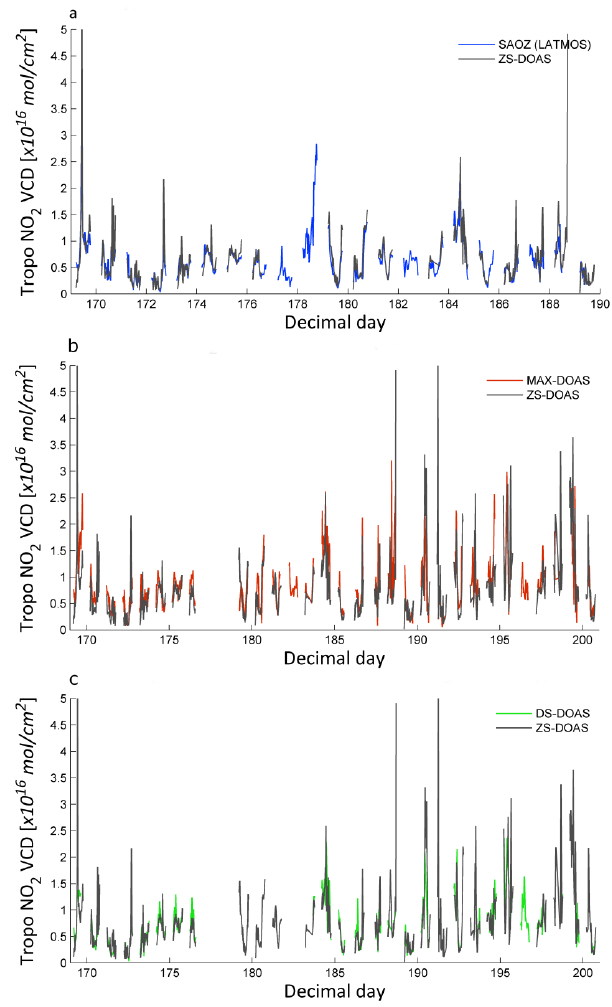
Figure 6. Comparisons of the tropospheric NO 2 VCD time se- ries, between (a) ZS-DOAS and SAOZ, (b) ZS-DOAS and MAX- DOAS, and (c) ZS-DOAS and DS-DOAS. TVCDs are binned and averaged in time slots of